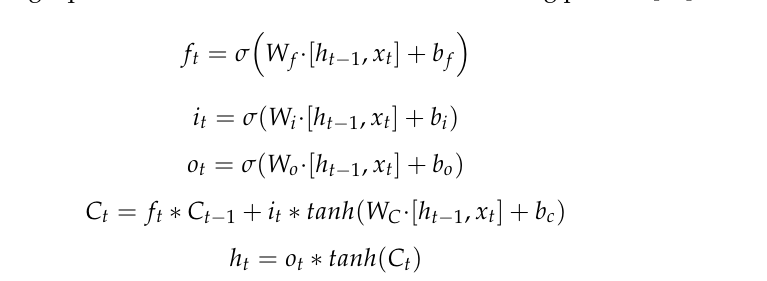
Figure 3. LSTM RNN elemental network structure.